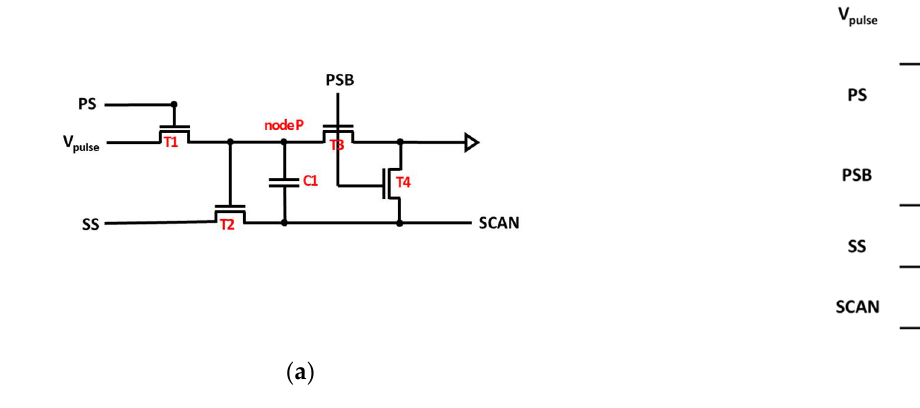
Figure 5. ( a ) Unit-stage modified bootstrap scan driver; ( b ) timing chart.